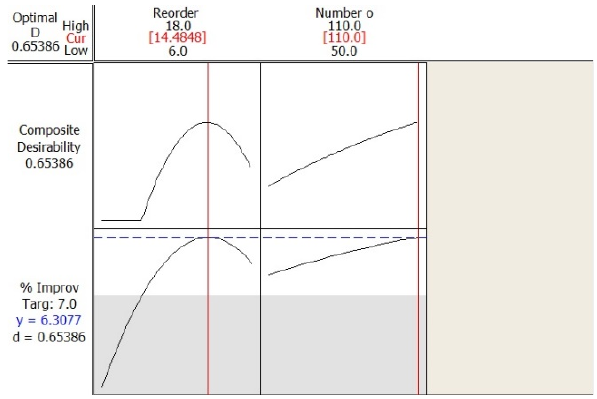
Fig. 12. Optimal point of the % improvement of tabu over the current practice (OUL) according to the parameters setting of the tabu search approach